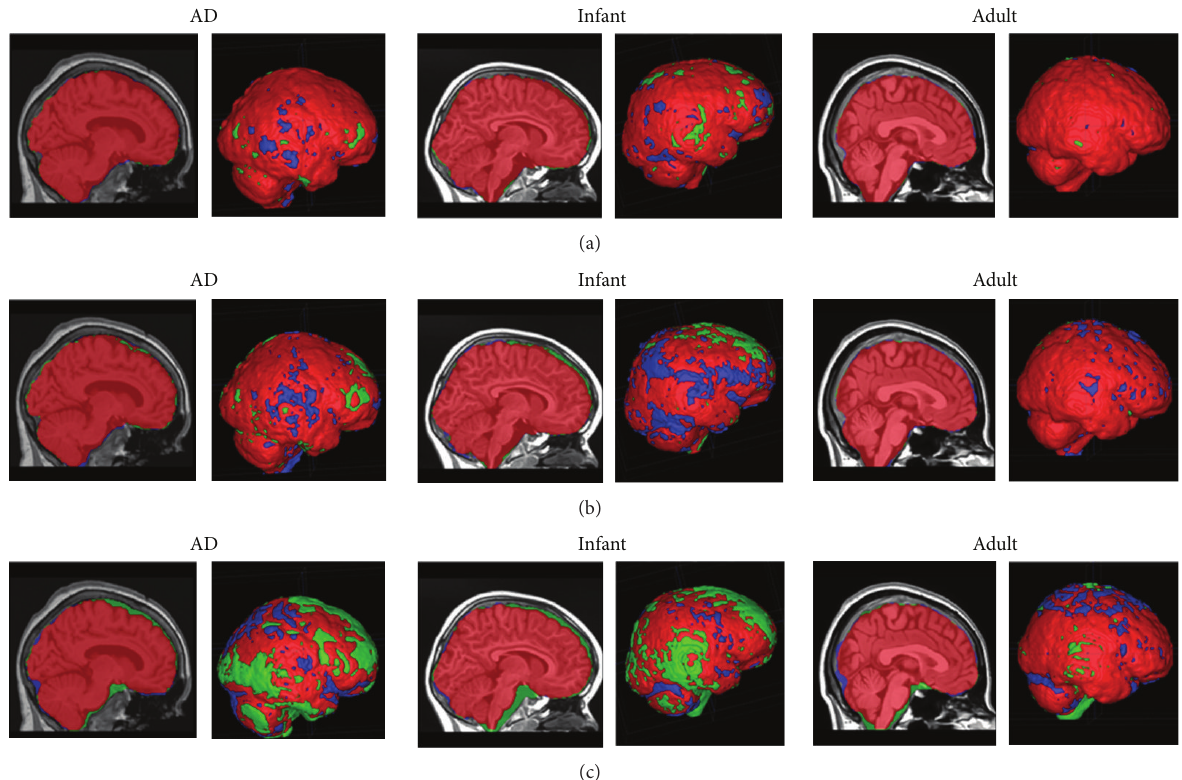
Figure6:ExamplesegmentationresultsusingNICE(a),BEaST(b),andVBM8(c)methodsonthethreedifferentpopulationsamples.Sagittal slices and 3D renderings of the segmentations are shown. Red voxels correspond to correct voxels in the segmentation compared to the gold standard. Blue voxels are false positives and green voxels are false negatives (AD case belongs to Oasis dataset and the adult and infant cases belong to the IXI dataset).